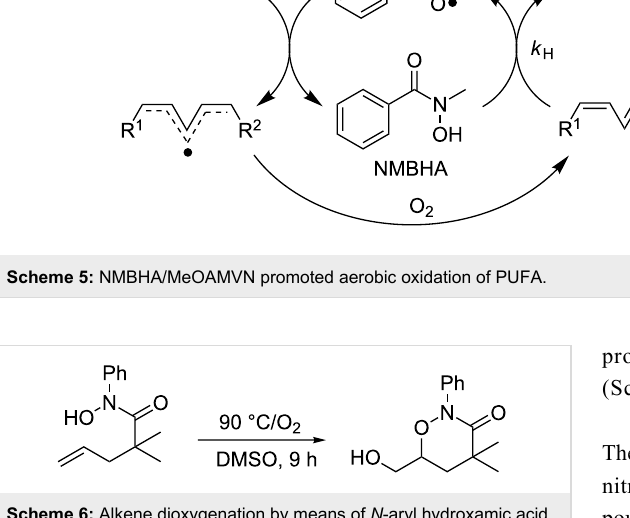
Scheme 6: Alkene dioxygenation by means of N -aryl hydroxamic acid and O 2 .